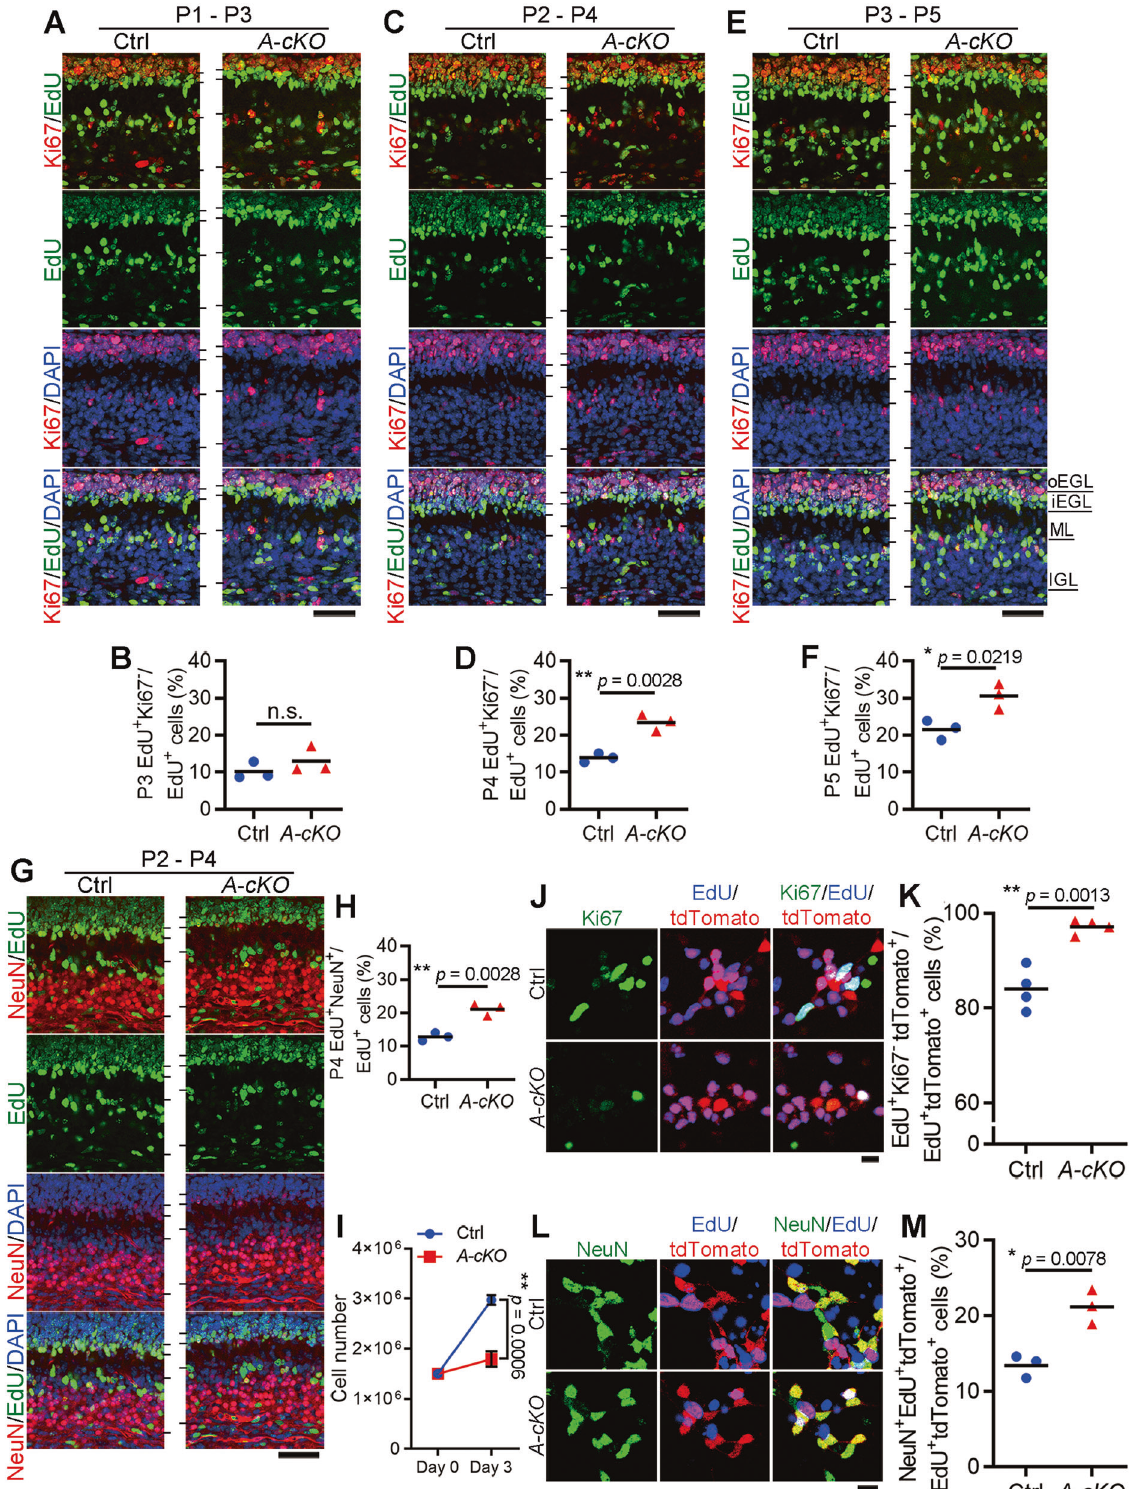
in vitro system. To this end, GNPs were isolated from P7 cerebella of Wdr4 A-cKO and control mice using Percoll density gradient [25], and ~85% of the isolated cells expressed the GNP marker Atoh1 (Fig. S5). The isolated GNPs were labeled immediately by EdU, cultured and harvested after 3 days in vitro (DIV) to